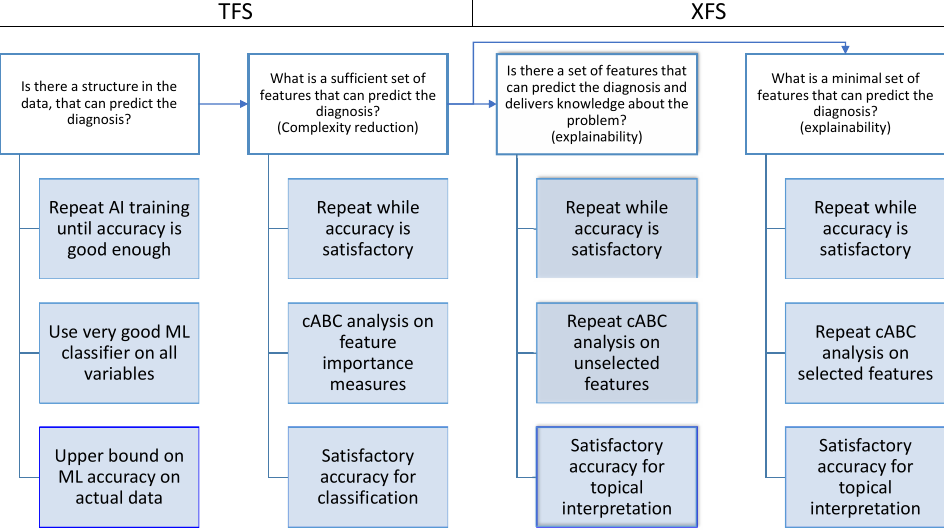
Figure 6. Flowchart showing the proposed feature selection workflow, with a distinction of the final goal into (i) “technical feature selection” (TFS), where the goal can be defined as training a powerful classifier, and (ii) “explainable feature selection” (XFS), where the goal can be defined that the selected features should be interpretable by a domain expert. Based on the evaluation of whether the entire input data space has a structure that matches the class structure of the output data space, for TFS the selected features are sufficient if the classifier computes the classification with the same accuracy as with all features in the data set. However, relevant information that makes the feature sets interpretable by the expert in the field may be lost in the process. For XFS, the selected features should therefore be interpretable by an expert in the field, i.e., they should contain relevant variables that provide information about the processes underlying the class structure. This can be facilitated by including the initially unselected features in the interpretation, as proposed in this report, or alternatively by reducing the data set to a bare informative